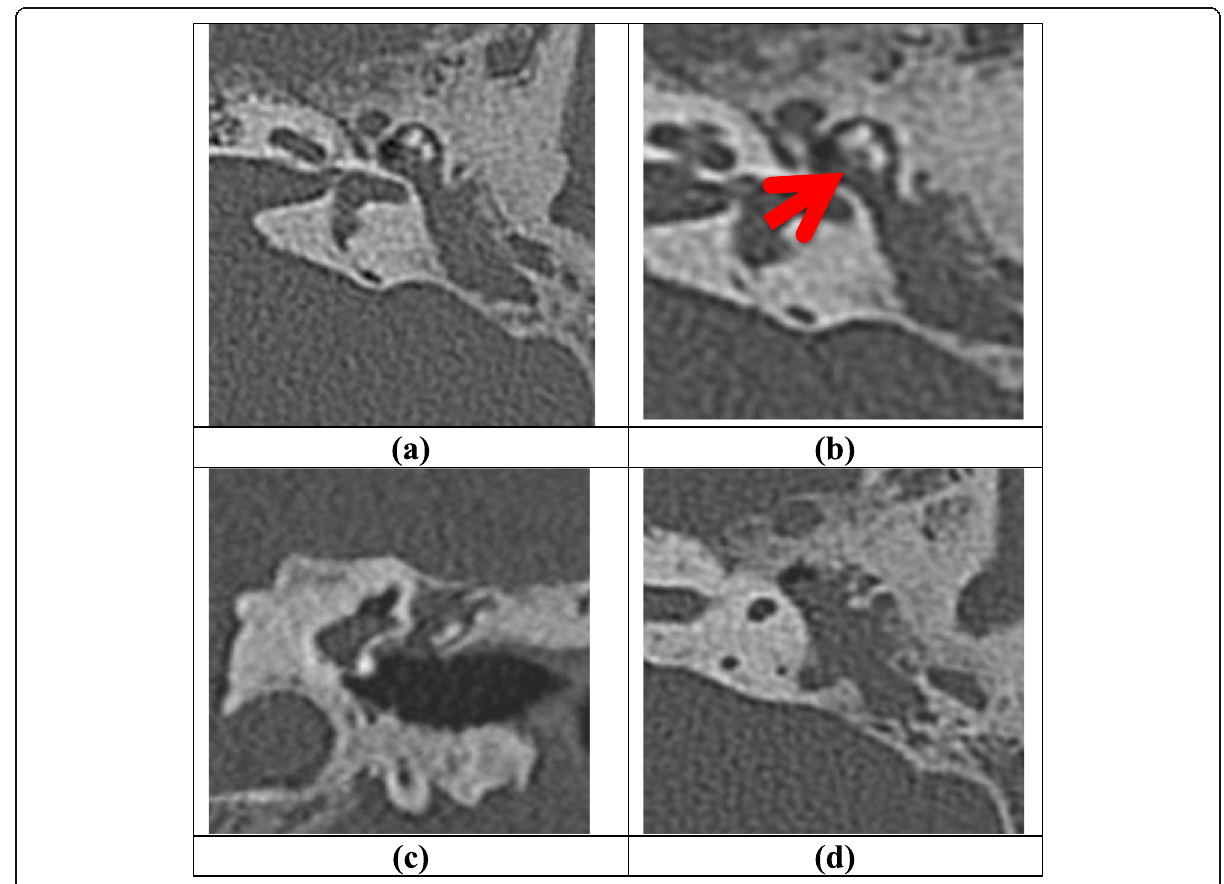
opacification is seen with failure to identify the Köerner ’ s septum